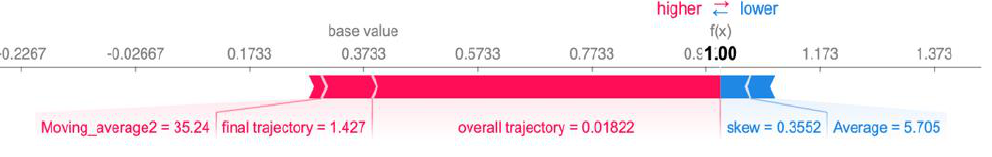
Figure 12. SHAP Force Plot 2 .